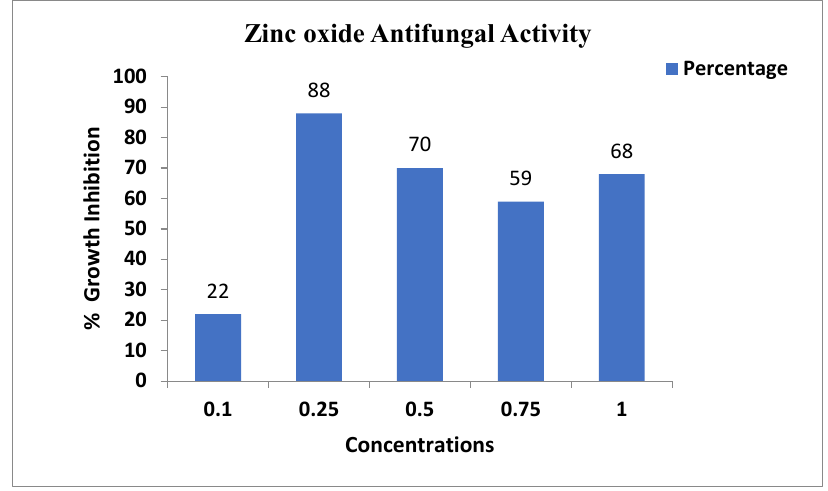
Figure 6. Antifungal activity of the zinc oxide nanoparticles against Aspergillus. Table 2. Antifungal activity of the zinc oxide nanoparticles. Concentration.